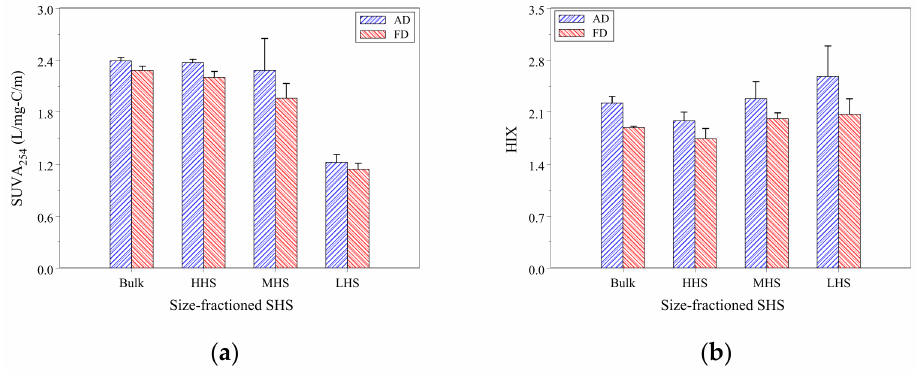
Figure 1. ( a , b ) Optical indicators varied with size-fractioned AEOM for AD and FD samples. The SUVA 254 and HIX values of the AD bulk SHS were significantly higher than the FD bulk SHS ( p = 0.047 and 0.018, respectively). In individual size-fractioned SHS samples, the SUVA 254 and HIX values of the AD samples were higher than the values of the FD samples, though insignificantly different (except the SUVA 254 of HHS). The high SUVA 254 and HIX values implied that the AD treatment had developed more aromatic functional groups and recalcitrant humic-like substances than the FD treatment due to biological activity. In the HHS samples, the average AD SUVA 254 value was significantly higher than the FD samples ( p = 0.02), consistent with the fluorescence regional integration (FRI) results. We compared the indicator difference between the size-fractioned SHS samples; for each sized SHS sample, the AD and FD samples were combined as a pooled